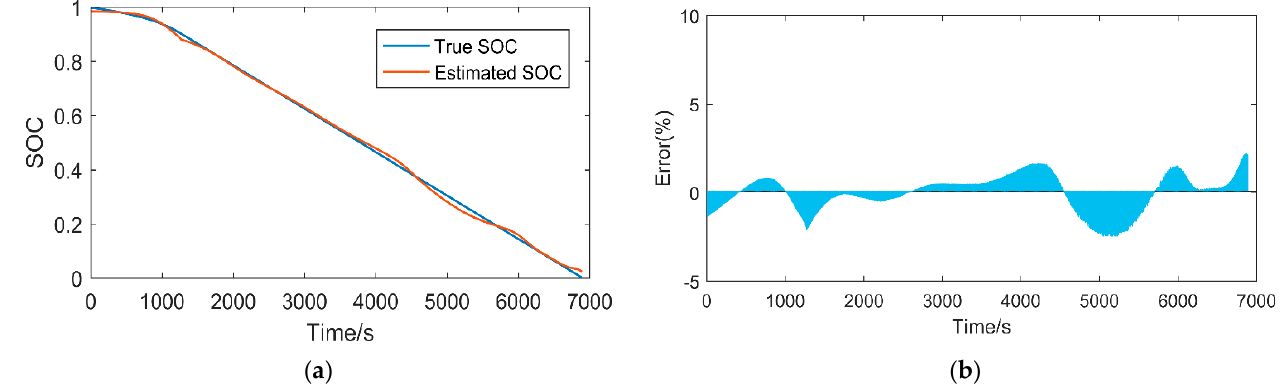
Figure 9. SOC estimation of the Bayes-BiLSTM model at 0 °C: estimated results ( a ) and estimated errors ( b ). Table 3. Comparison of the model estimation results after improving the recurrent block.